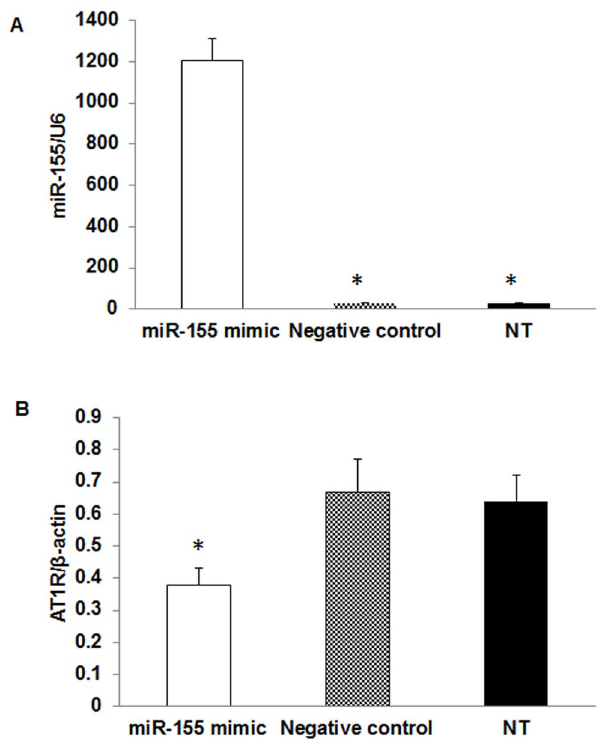
Figure 4. Overexpression of miR-155 and AT1R expression in VSMC from CKD rats. Rat VSMC isolated from CKD rats were transfected with 30 nM of miR-155 mimic or miR negative control for 48 hrs. Non-transfected VSMC (NT) was also used as control. The overexpression of miR-155 in VSMC was confirmed by real time PCR (A). The miR-155 target gene AT1R expression in VSMC was also determined by real time PCR, demonstrating a significant inhibition of AT1R expression compared to that with negative control or non- transfected VSMC (B). Data were expressed as mean 6 SEM (n=3 separate experiments). *p , 0.05, miR-155 mimic vs. negative control or NT.